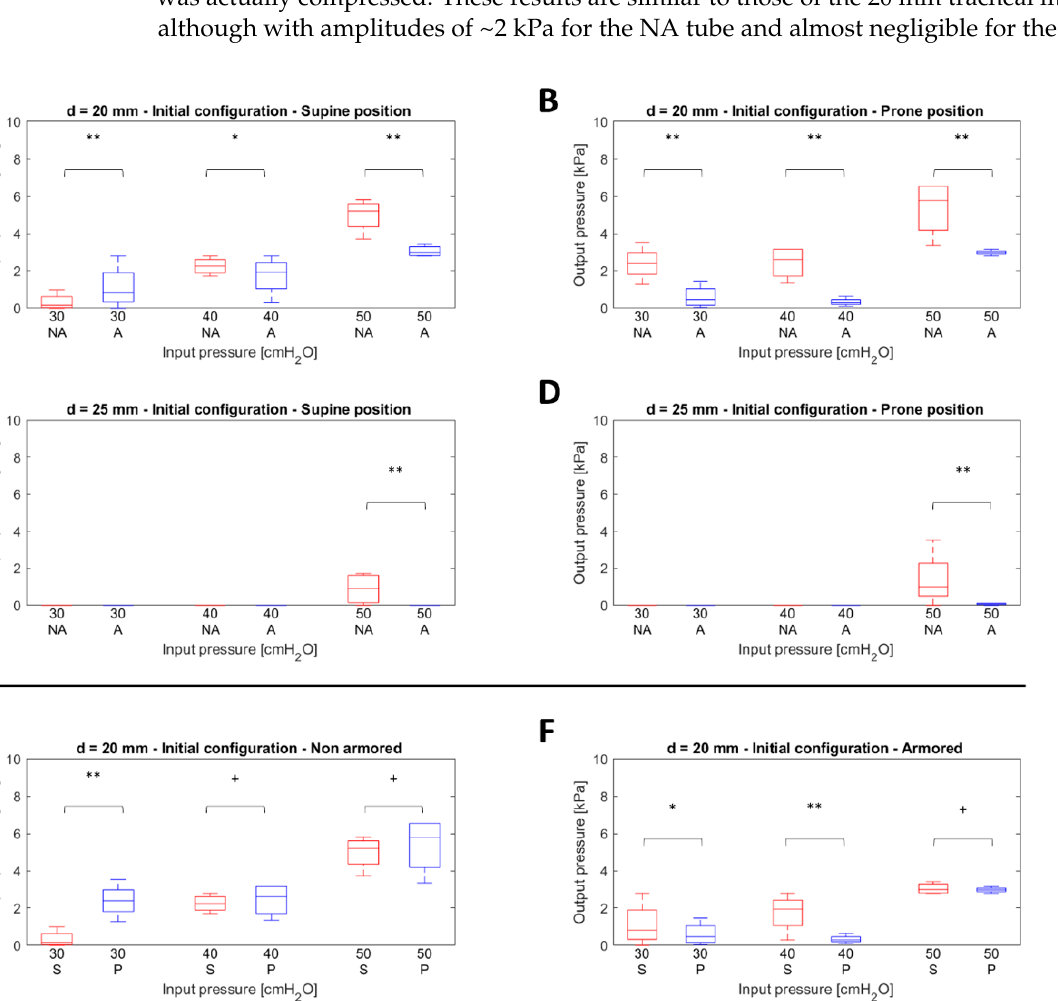
Figure 4. Statistical analysis to determine the differences in pressure, if any, before performing a maneuver. ( A – D ) Box plots showing the comparison between non-armored (NA) and armored (A) tubes across diameters of the trachea and position (S—supine, P—prone). ( E – H ) Box plots showing the comparison between body position (S/P) against diameters and type of endotracheal tube (NA/A). Legend: ** p < 0.001, * 0.002 < p ≤ 0.05, and + p > 0.05.